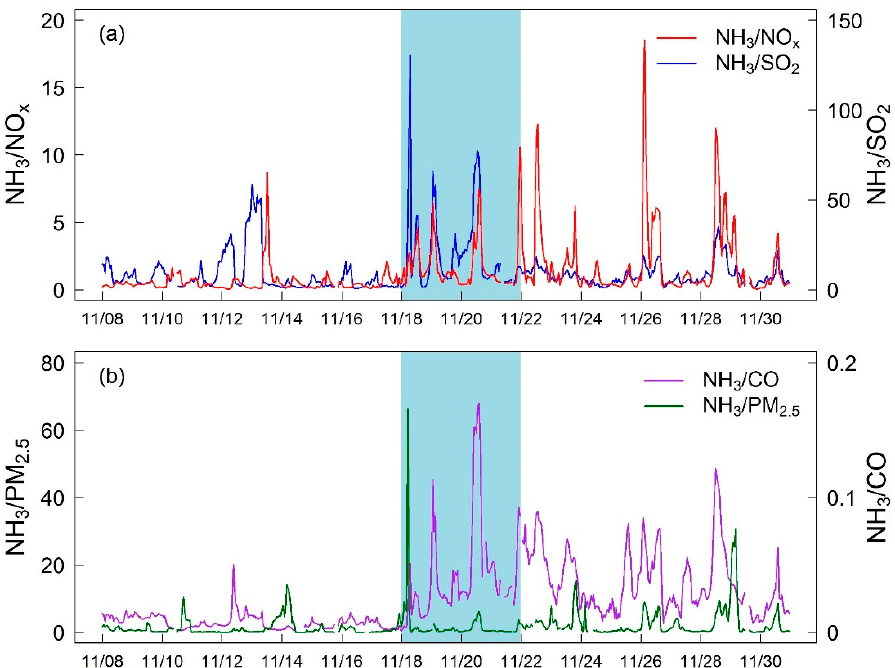
Figure 4. Temporal variation in the ratio of NH 3 relative to NO X , SO 2 ( a ), CO and PM 2.5 ( b ). Table 2. Summary of the NH 3 concentration and its emission ratio (ER = ∆ NH 3 / ∆ CO) in different burn events.